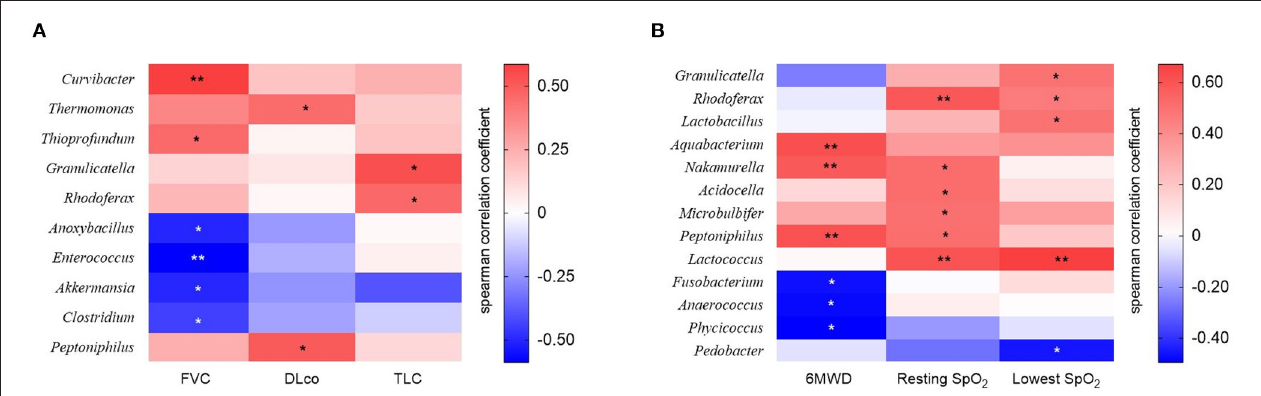
Frontiers in Medicine |